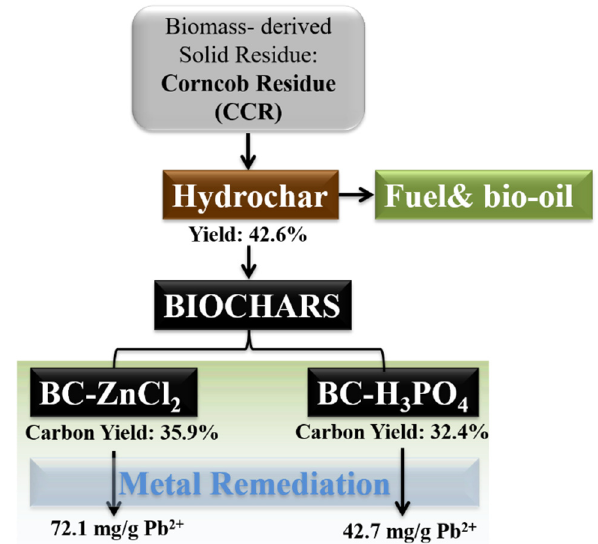
Figure 7. Concept of the biomass-derived biochar for Pb 2 + remediation.